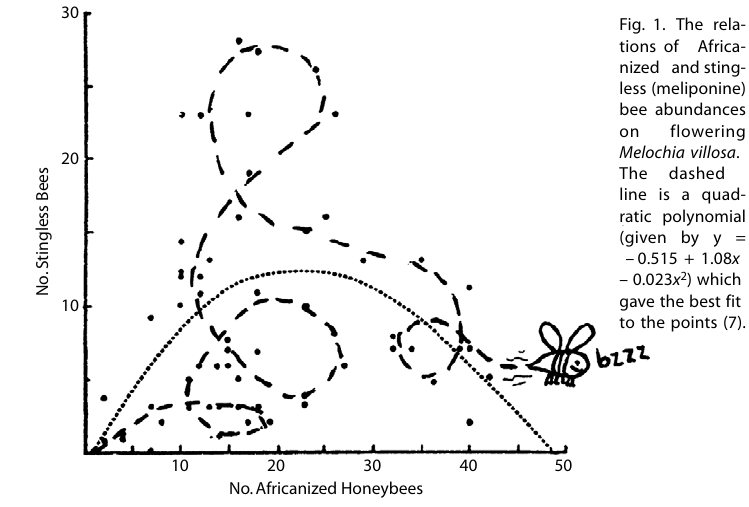
Figure. 1 Robert M Hazen’s observations on curve fitting. Reproduced with permission from Ref. [2]. similarities between groups, the list of exclusion criteria is often quite wide and includes patients with more severe forms of disease or ones with comorbidities. Thus, as these criteria become more restrictive or ‘‘exclusive’’, generalizing the results to daily practice (external validity) becomes more difficult. An example is excluding patients with reduced ejection fraction from studies on valvular surgery. All too often, results will be extrapolated to all categories of patients with varying ejection fractions, yet strictly speaking, if the real-life patient does not meet the inclusion/exclusion criteria of the study, it is less accurate to apply the